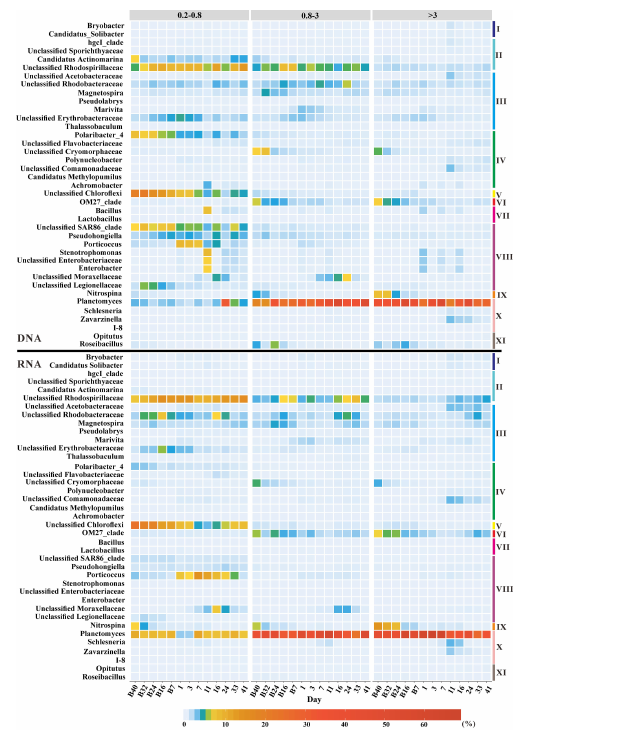
FIGURE 1 Bacterial communities at the genus level based on DNA (top panel) and RNA (bottom panel) libraries from the 0.2 – 0.8-µm-, 0.8 – 3-µm-, and >3-µm-size fractions. Groups with relative abundance of not less than 5% in at least one sample were shown in the graph. I, Acidobacteria; II, Alphaproteobacteria; III, Bacteroidetes; IV, Betaproteobacteria; V, Chloro fl exi; VI, Deltaproteobacteria; VII, Firmicutes; VIII, Gammaproteobacteria; IX, Nitrospinae; X, Planctomycetes; XI,